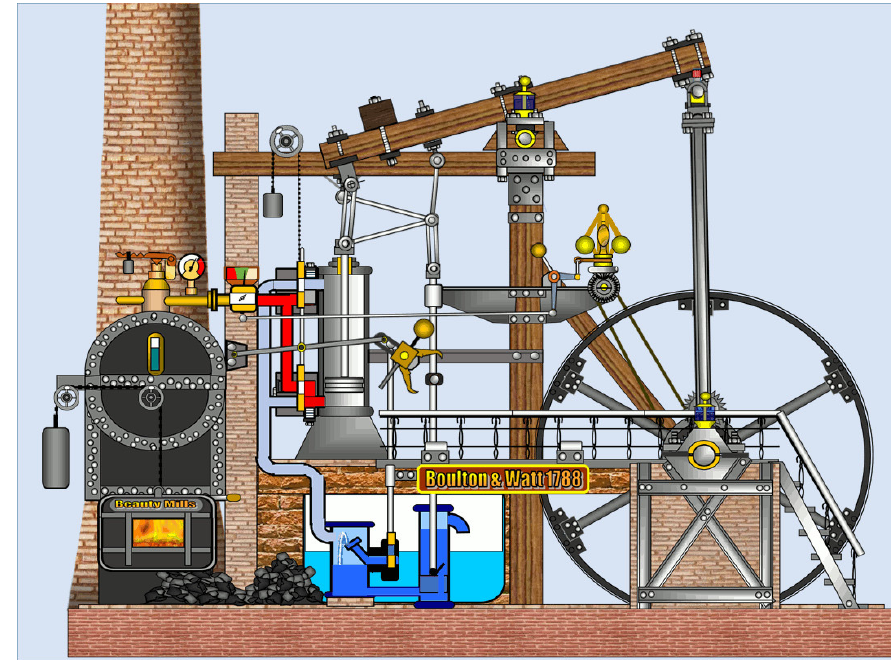
Fig. 3. – The Steam Engine of James Watt and Mathew Bolton